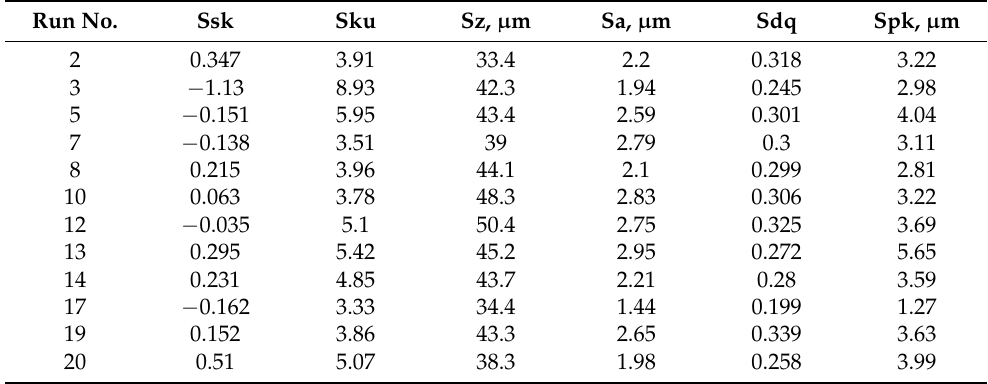
Table 5. Surface roughness parameters measured on the inner surface of the drawpieces. Run